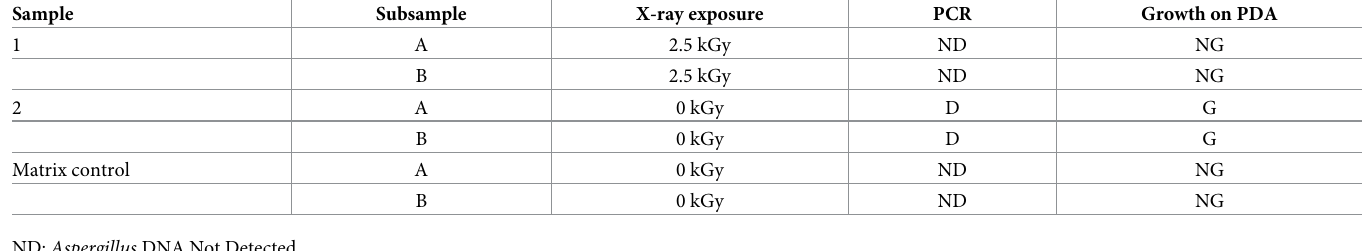
Table 7. 100 g cannabis flower scale-up experiment.